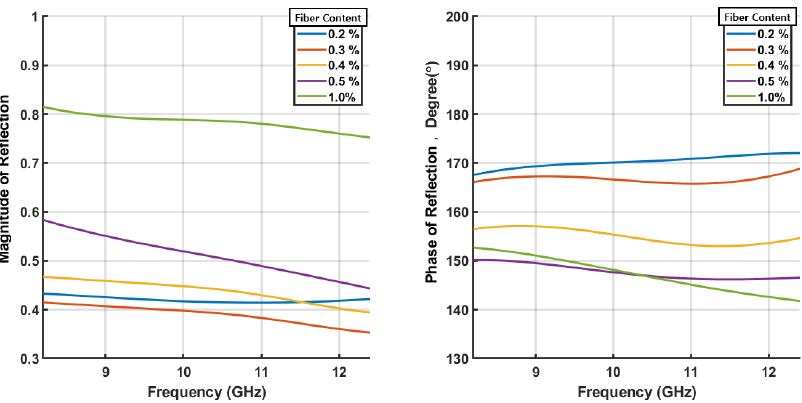
Figure 8. Reflection coefficient of each specimen of the steel fiber reinforced concrete